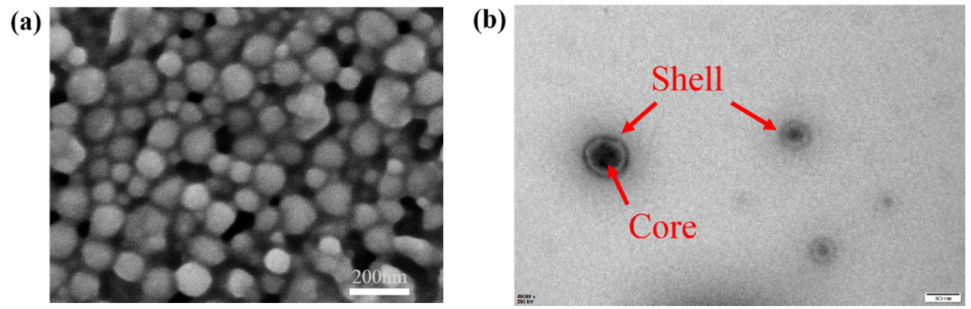
Figure 6. Microstructure of PS microspheres ( a ) SEM image; ( b ) TEM